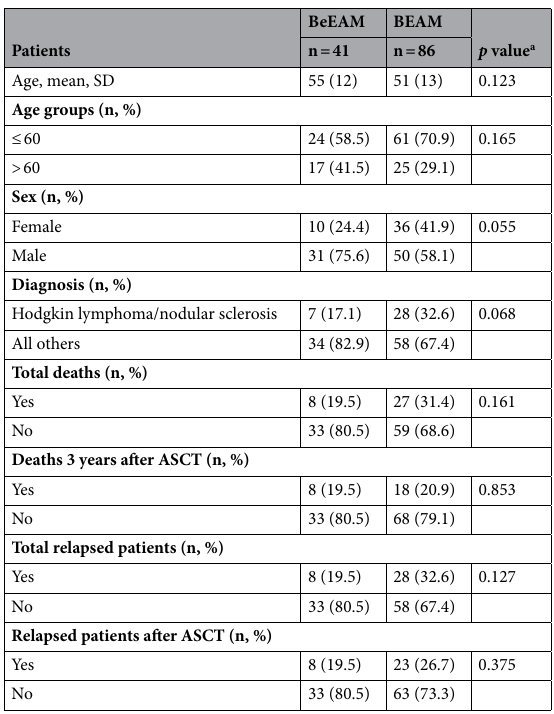
Table 1. Patient characteristics. a Chi-square test: ASCT autologous stem cell